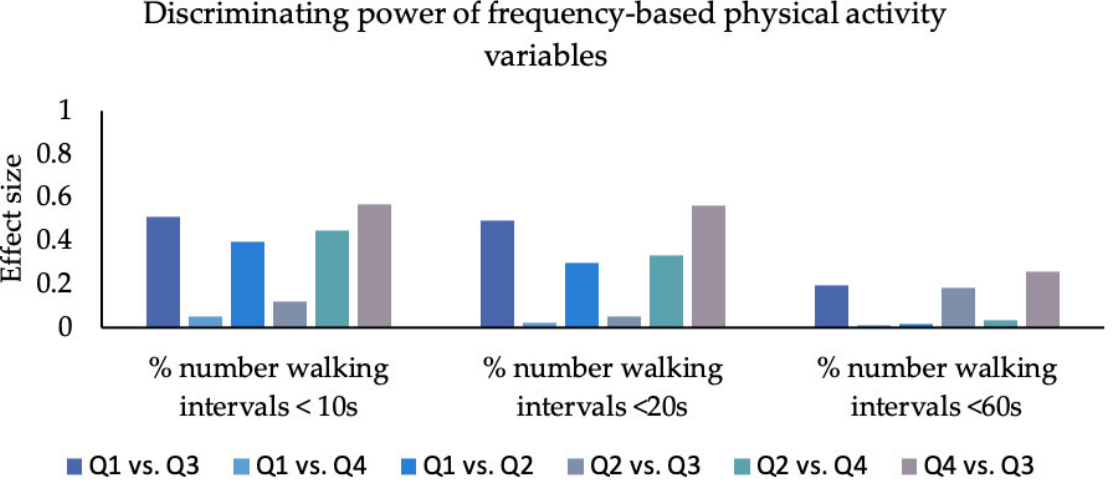
Figure 4. The effect size for each group comparison for frequency-based PA variables. Q1: 1. quadrant (can do–do do), Q2: 2. quadrant (cannot do–do not do), Q3: 3. quadrant (can do–do not do), Q4: 4. quadrant (cannot do–do do); percentage (%) number of walking intervals < 10 s, percentage (%) number of walking intervals length < 20 s, percentage number of walking intervals length < 60 s.